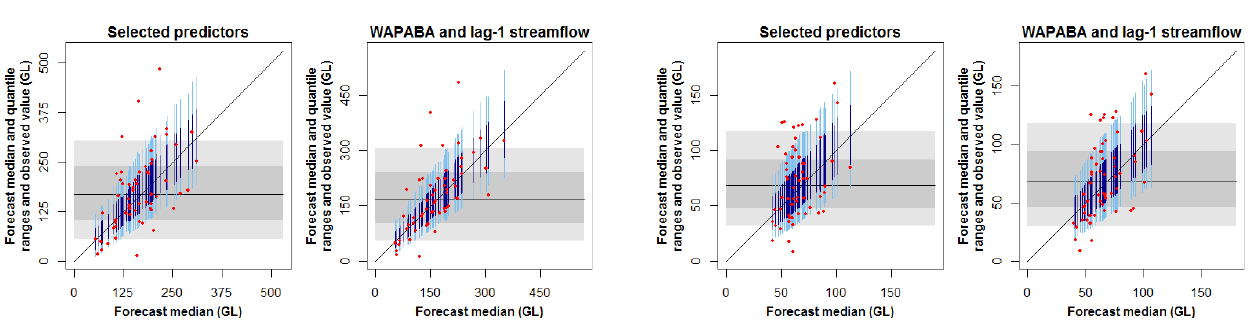
Fig. 8. Forecasts of inflows into Dartmouth Reservoir for the November-December-January season. Using selected predictors, RMSEP skill score=19% and CRPS skill score=17%, using WA- PABA simulations and lag-1 streamflow as predictors RMSEP skill score=31%, and CRPS skill score=28%. (legend as per Fig. 7).